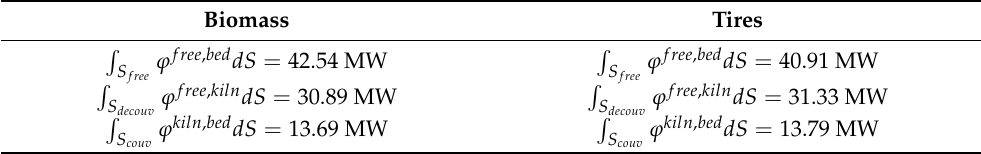
Figure 4. Comparison of the temperature profiles obtained with two alternative fuels (above: biomass; below: tires). Table 10. Characteristics of the flows exchanged in the two substitution